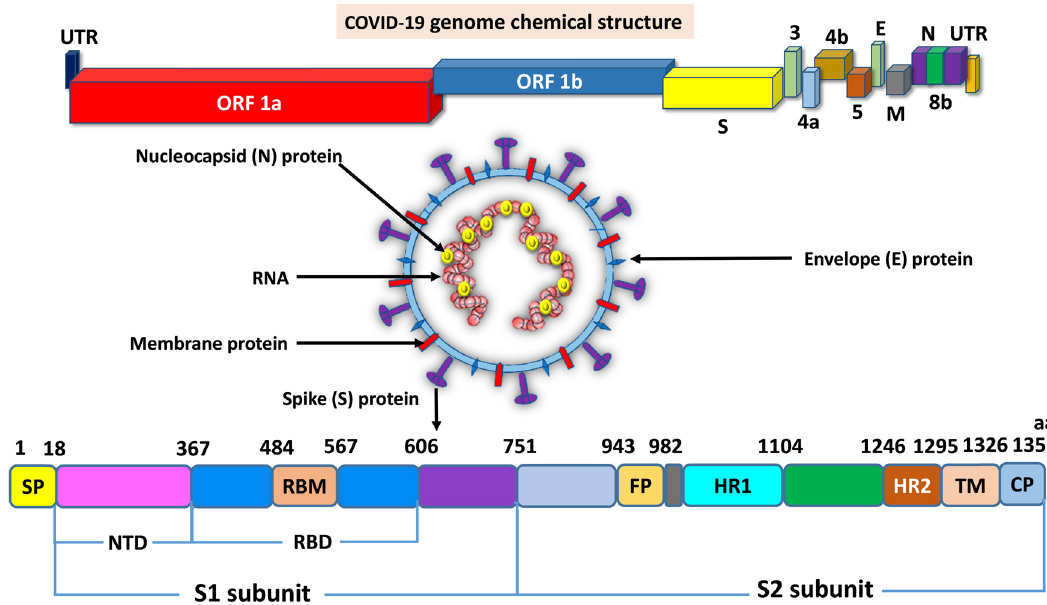
Figure 1: Schematic structure of SARS - CoV - 2